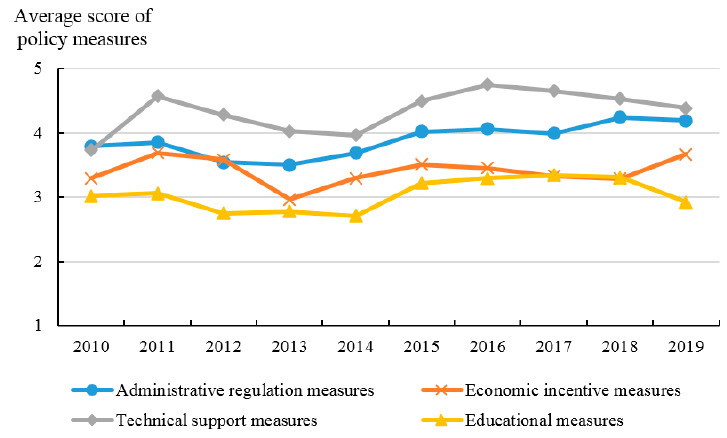
Figure 7. Average score of policy monitoring from 2010 to 2019.